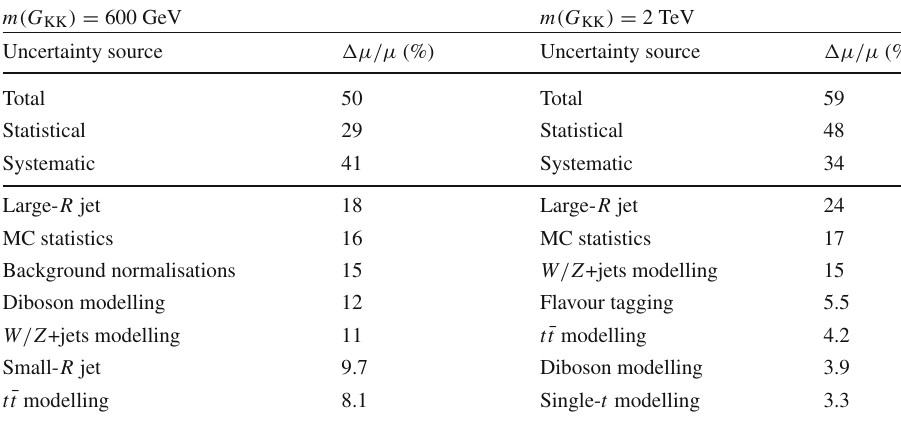
uncertainties in the best-fit signal-strength parameter μ of hypothesised signal production of ggF RS graviton with m ( G KK ) = 600 GeV and m ( G KK ) = 2 TeV. For this study, the RS graviton production cross-section is assumed to be 100 fb at 600 GeV and 2 fb at 2 TeV, corresponding to approximately the expected median upper limits at these two mass values. Uncertainties with smaller contributions are not